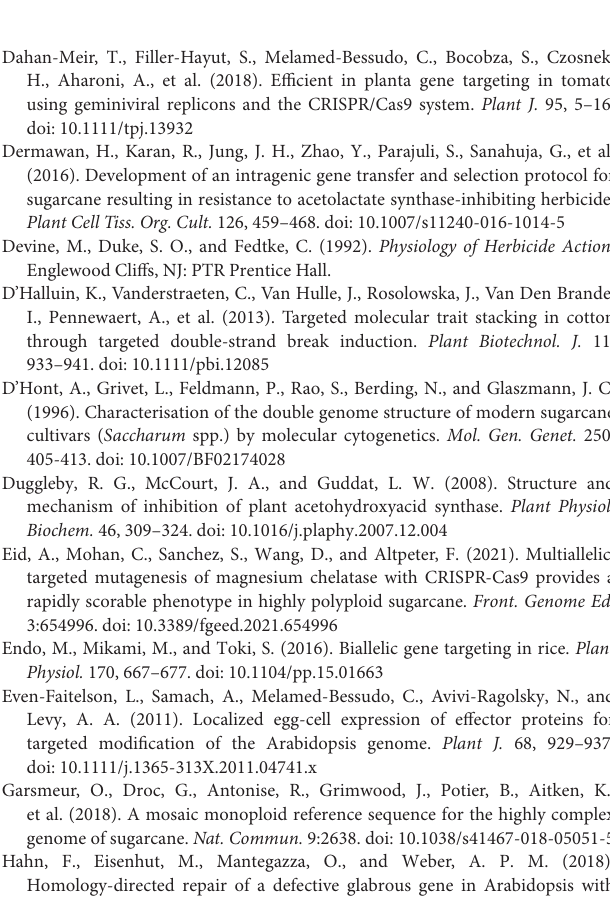
Supplementary Figure 4 | Electrophoretic separation of cleavage products after in vitro Cas9 nuclease assay. Cleavage with commercially available Cas9 protein confirmed that both sgRNAs (sgRNA 574 and sgRNA 653 ) effectively targeted Cas9 to induce double strand breaks at the target sites in the ALS gene. M, marker. Supplementary Figure 5 | Targeted nucleotide substitutions in the sugarcane ALS gene in lines L3 and L7, 300 and 374 nt from the DNA double strand break, respectively, targeted with a single gRNA as determined by Sanger sequencing of cloned PCR amplicons. Homology-directed repair-mediated CRISPR/Cas9 gene targeting edits are shown in red bold font and underlined. The four targeted nucleotide substitutions were highlighted in the template in black bold font compared to the wild-type ALS sequence. Naturally occurring non-target single nucleotide polymorphisms (SNPs), used to identify alleles, are indicated with lowercase black letters. The single sgRNA sequence used in this treatment (Treatment 1, Table 2 ) is highlighted in gray. Homology-directed repair-mediated nucleotide substitutions of S653I and PAM2 are shown in edited lines L3 and L7. Numbering follows the 1,913 bp PCR amplicon of ALS alleles. Supplementary Table 1 | Sequence of expression cassettes carrying gRNAs. Supplementary Table 2 | Sequence of sugarcane ALS gene and repair template. Supplementary Table 3 | Primer and probe sequences.